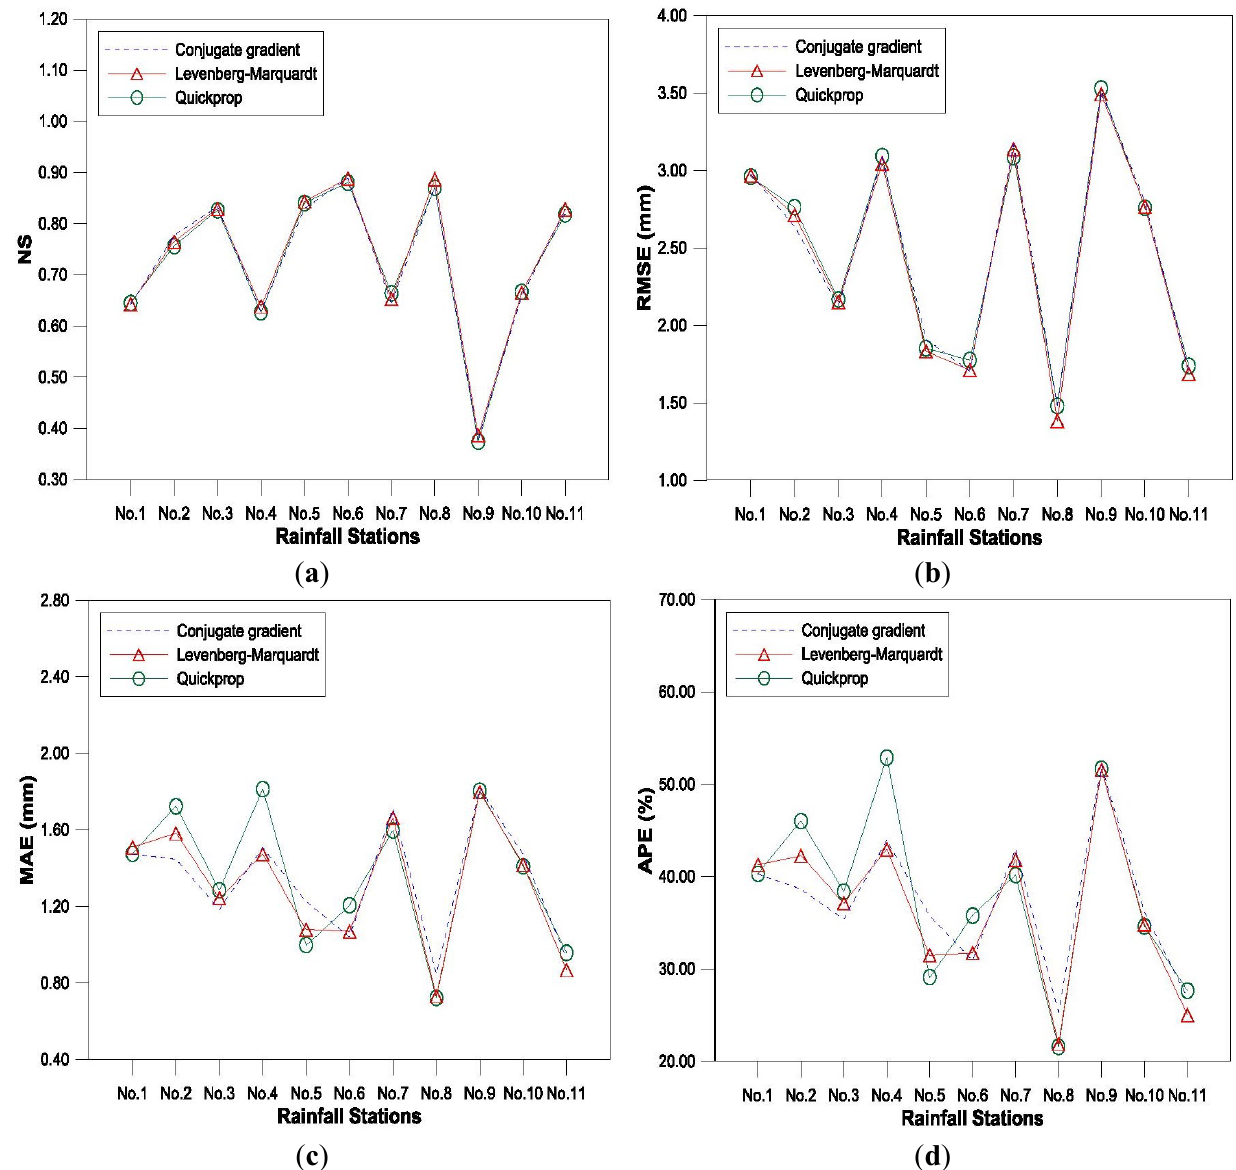
Figure 5. Influence of individual rainfall stations for three training algorithms of MLP (test period). ( a ) NS; ( b ) MAF; ( c ) RMSE; ( d )